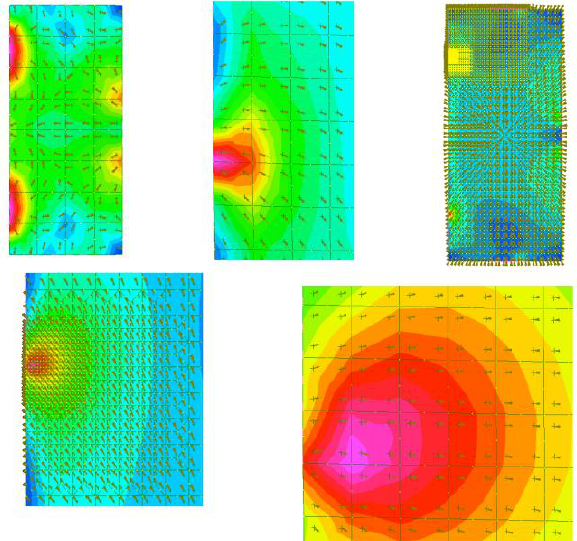
Figure 6. Representation of different meshing of the area corresponding to the doorway of the